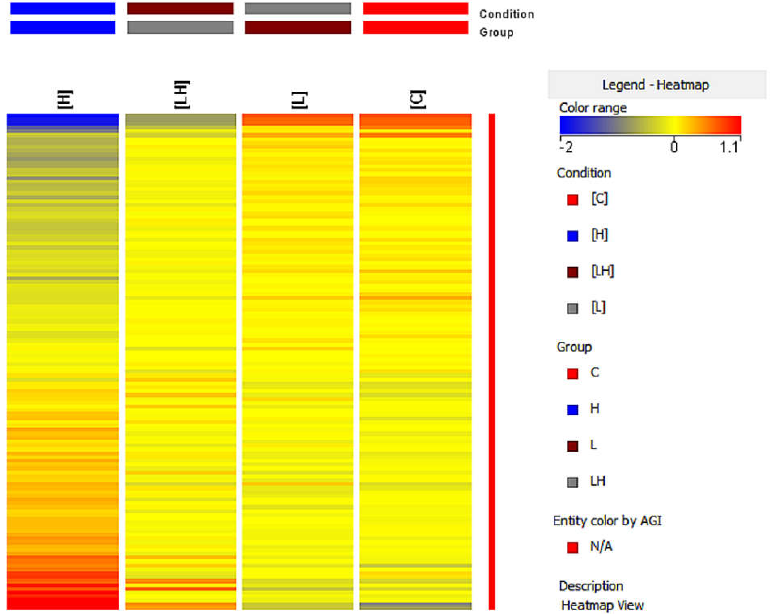
Figure 5. Fluorescence signal intensity maps specific to 128 ID mRNA pyroptosis-related genes specific to the control ARPE--19 cells (C), lutein-treated ARPE-19 cells (L), H 2 O 2- -treated ARPE-19 cells (H), and lutein-- and H 2 O 2 -treated ARPE-19 cells (LH). Blue—indicates the lowest values and red— indicates the highest values of fluorescence signals.